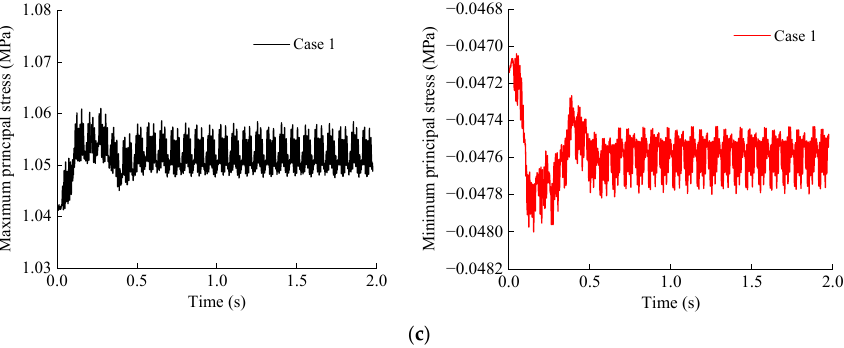
Figure 13. Time–history curve of principal stress at each measuring point of base structure: ( a ) Meas- uring point A; ( b ) Measuring point B; ( c ) Measuring point C. The principal stress peaks of each measuring point of the basement structure for dif- ferent softening degrees of the bedrock are extracted, as shown in Table 5, and drawn on the graph shown in Figure 14. It can be seen from Table 5 and Figure 14 that the maximum and minimum principal stresses at each measuring point of the tunnel base increase con- tinuously with the decrease in the softening coefficient. Specifically, after the softening coefficient value is 0.5, the principal stress increases obviously with the increase in the softening degree. When the softening coefficient of the bedrock is 0.1, the maximum ten- sile stress peak occurs at measuring point B, which is 1.158 MPa, followed by that of the measuring point C, which is 1.109 MPa, reaching 75.2% and 72.0% of the structural allow- able tensile strength standard, respectively. The maximum compressive stress peak occurs